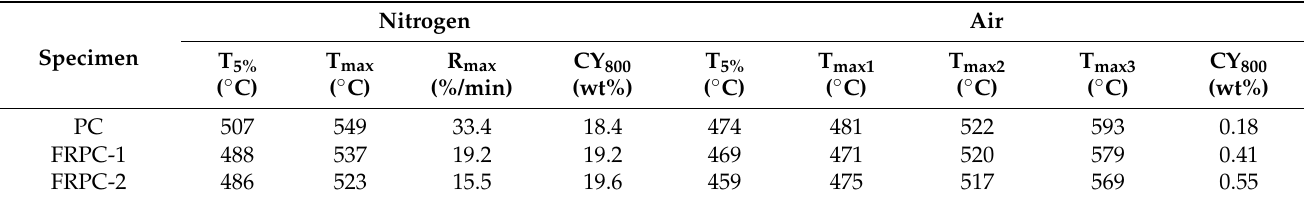
Table 2. Thermal parameters for PC and